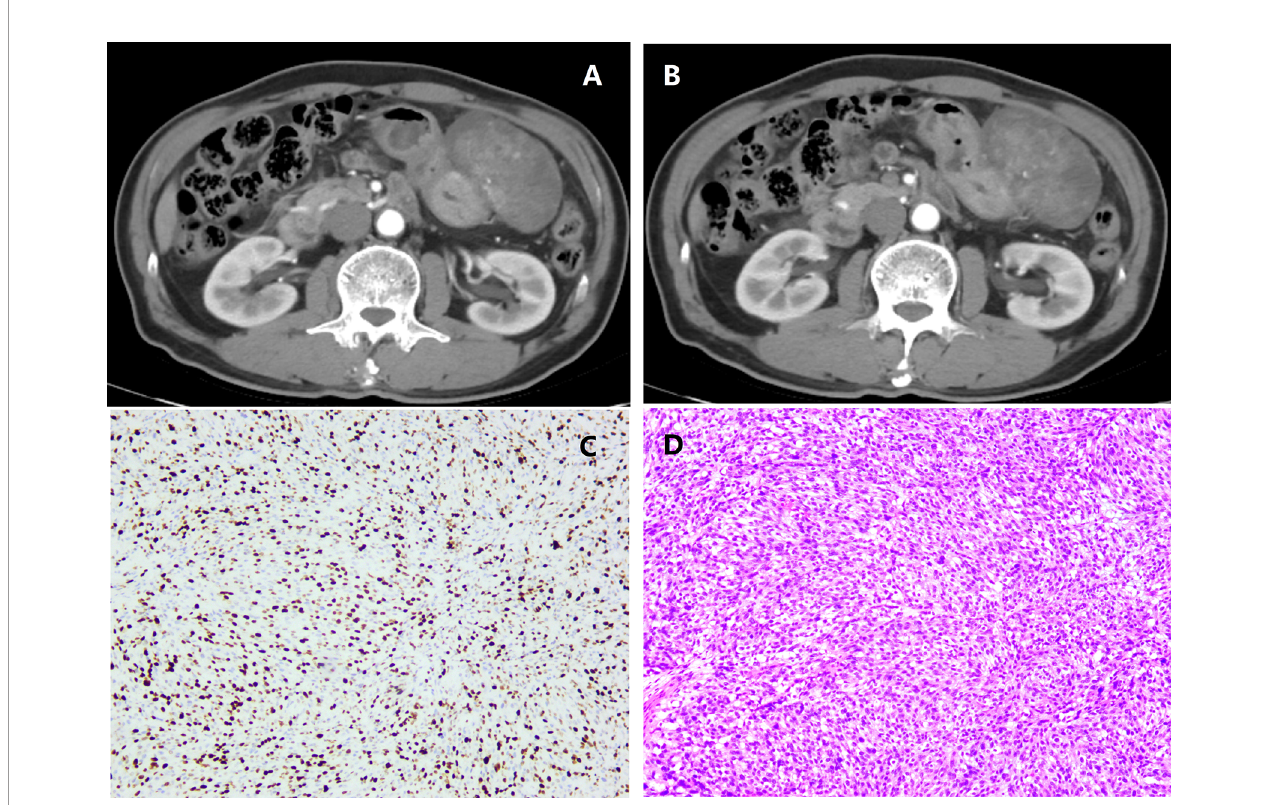
FIGURE 1 | A patient with intestinal gastrointestinal stromal tumor (GIST) belonging to the high malignant potential. (A) Arterial phase; (B) Venous phase; (C) Immunohistochemical photomicrograph showed a high Ki67 index (about 35%, original magni fi cation, ×10); (D) Pathology demonstrated a high-risk GIST with a high mitotic rate (>4/HPF, original magni fi cation,